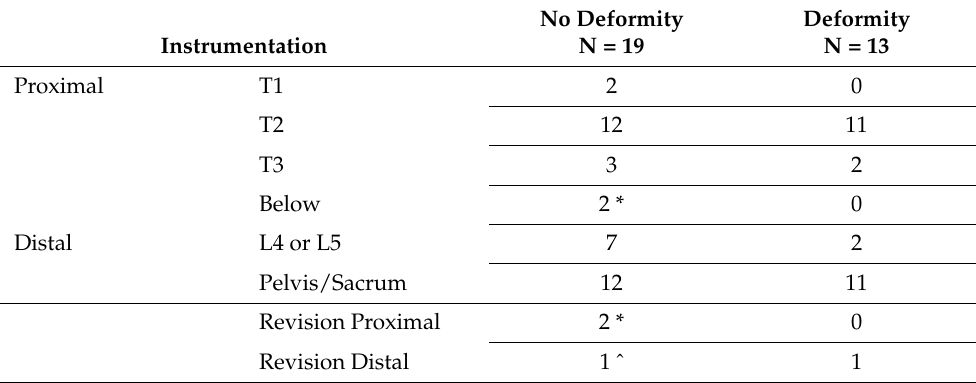
Table 7. Comparison of instrumentation between those with and without deformities.